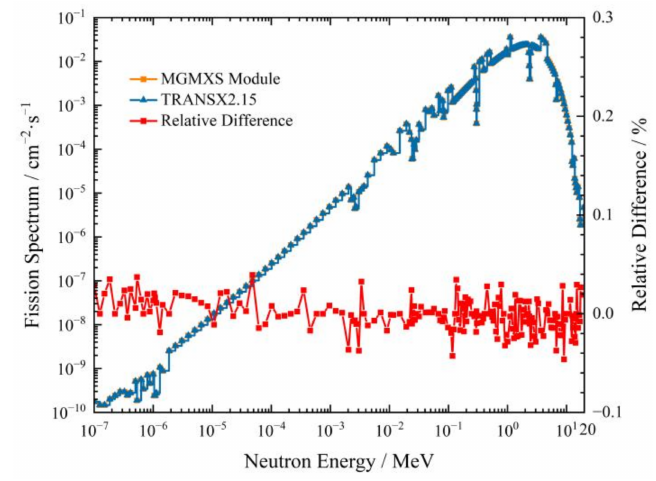
Figure 5. The relative differences of fission